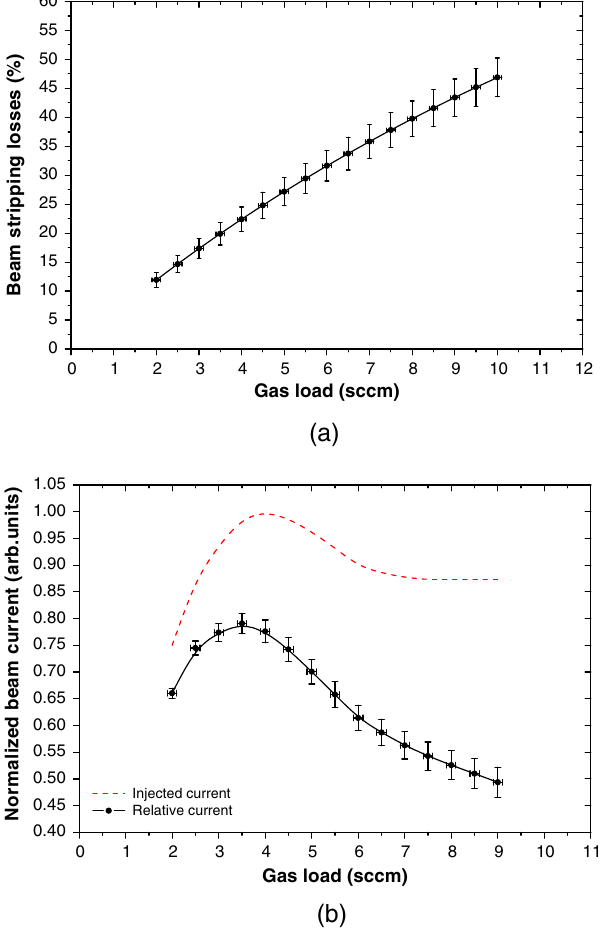
FIG. 6. (a) Stripping losses rate as a function of the gas load of the chimney. (b) Relative final beam current from stripping losses simulations considering the experimental results of the ion source extraction measurements. To facilitate the data analysis, the red dashed line represents the normalized injected current over the maximum from the experimental measurements [48].